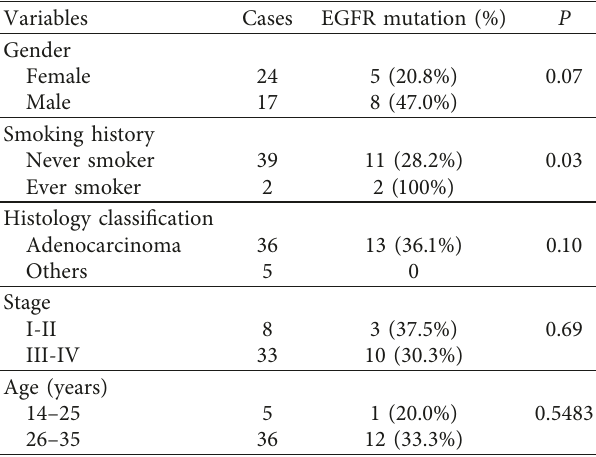
Table 3: Patient characteristics and EGFR